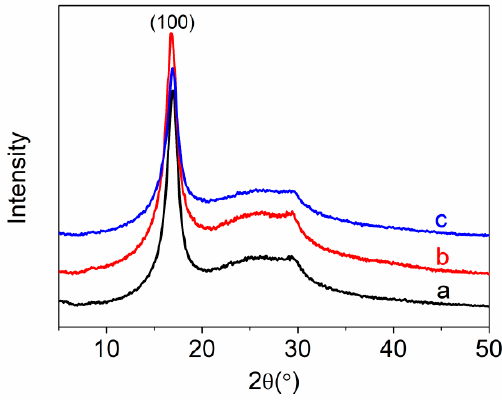
Figure 4. X-ray Di ff raction (XRD) patterns of ( a ) PAN homopolymer, ( b ) PAN-IA0.5 copolymers, Figure 4. X-ray Diffraction (XRD) patterns of ( a ) PAN homopolymer, ( b ) PAN-IA0.5 copolymers, and and ( c ) PAN-IA1.0 copolymers. ( c ) PAN-IA1.0 copolymers.